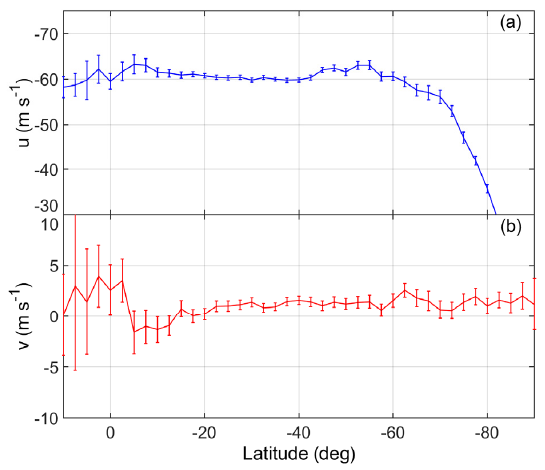
Figure 8. Mean profiles of the zonal ( a ) and meridional ( b ) winds in the lower clouds of Venus on the nightside from the full VIRTIS-M dataset. The average values were calculated for 2.5 ◦ latitude bins. Error bars show standard errors for a 99% confidence interval.